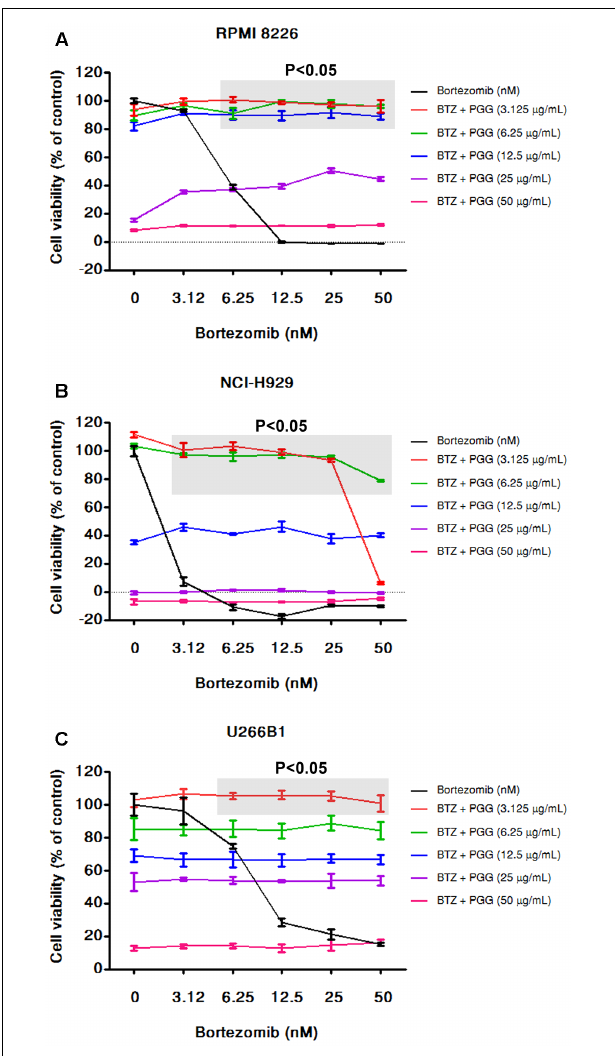
FIGURE 5 | PGG sensitizes the effect of MG132 to inhibit MM cells growth. RPMI 8226 (A) , NCI-H929 (B) , and U266B1 (C) cells were cultured with the indicated concentrations of PGG (3.125–50 µ g/mL) and MG132 (0.0022–0.625 µ M) both alone and in combinations for 72 h. Cell viability was assessed by alamarBlue R (cid:13) assay and presented as described in Section “Materials and Methods.” The percentage of viable cells normalized to solvent treated control were plotted after background subtraction. Results are means ± SD ( n =